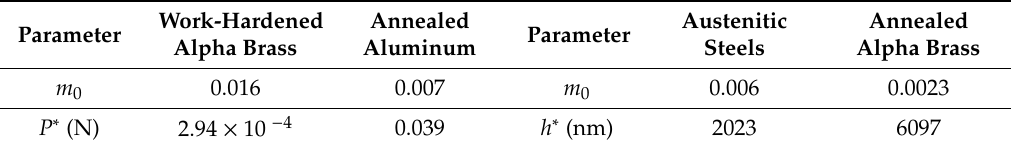
Figure 2. Strain rate sensitivity m -loading force P relationships compared between the experimental data (black dots) and theoretical results (red lines) of ( a ) work-hardened mechanically polished alpha brass [49] and ( b ) annealed aluminum [8]. The inset figure illustrates the calibration of model parameters by comparison with experimental data. Table 1. Model parameters for work-hardened alpha brass [49], annealed aluminum [8], austenitic steels [38] and annealed alpha brass [35].